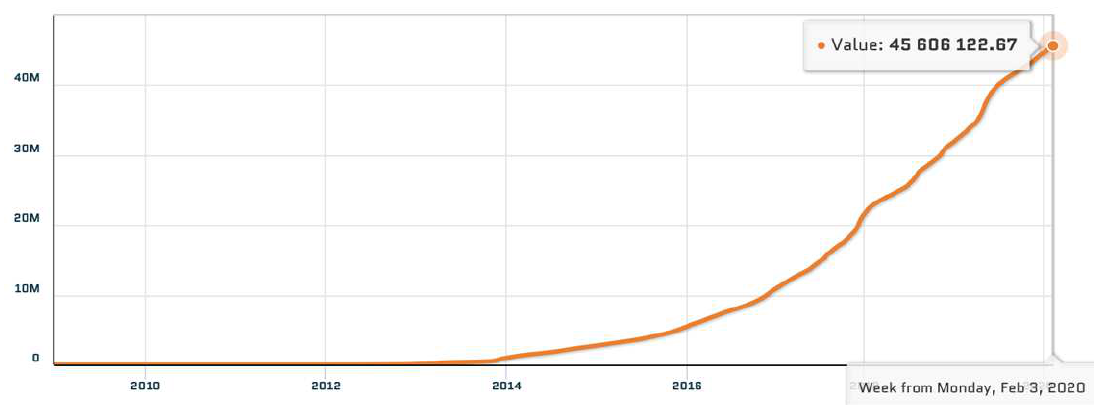
Figure 3. The number of Bitcoin wallet holders as of February 5, 2020